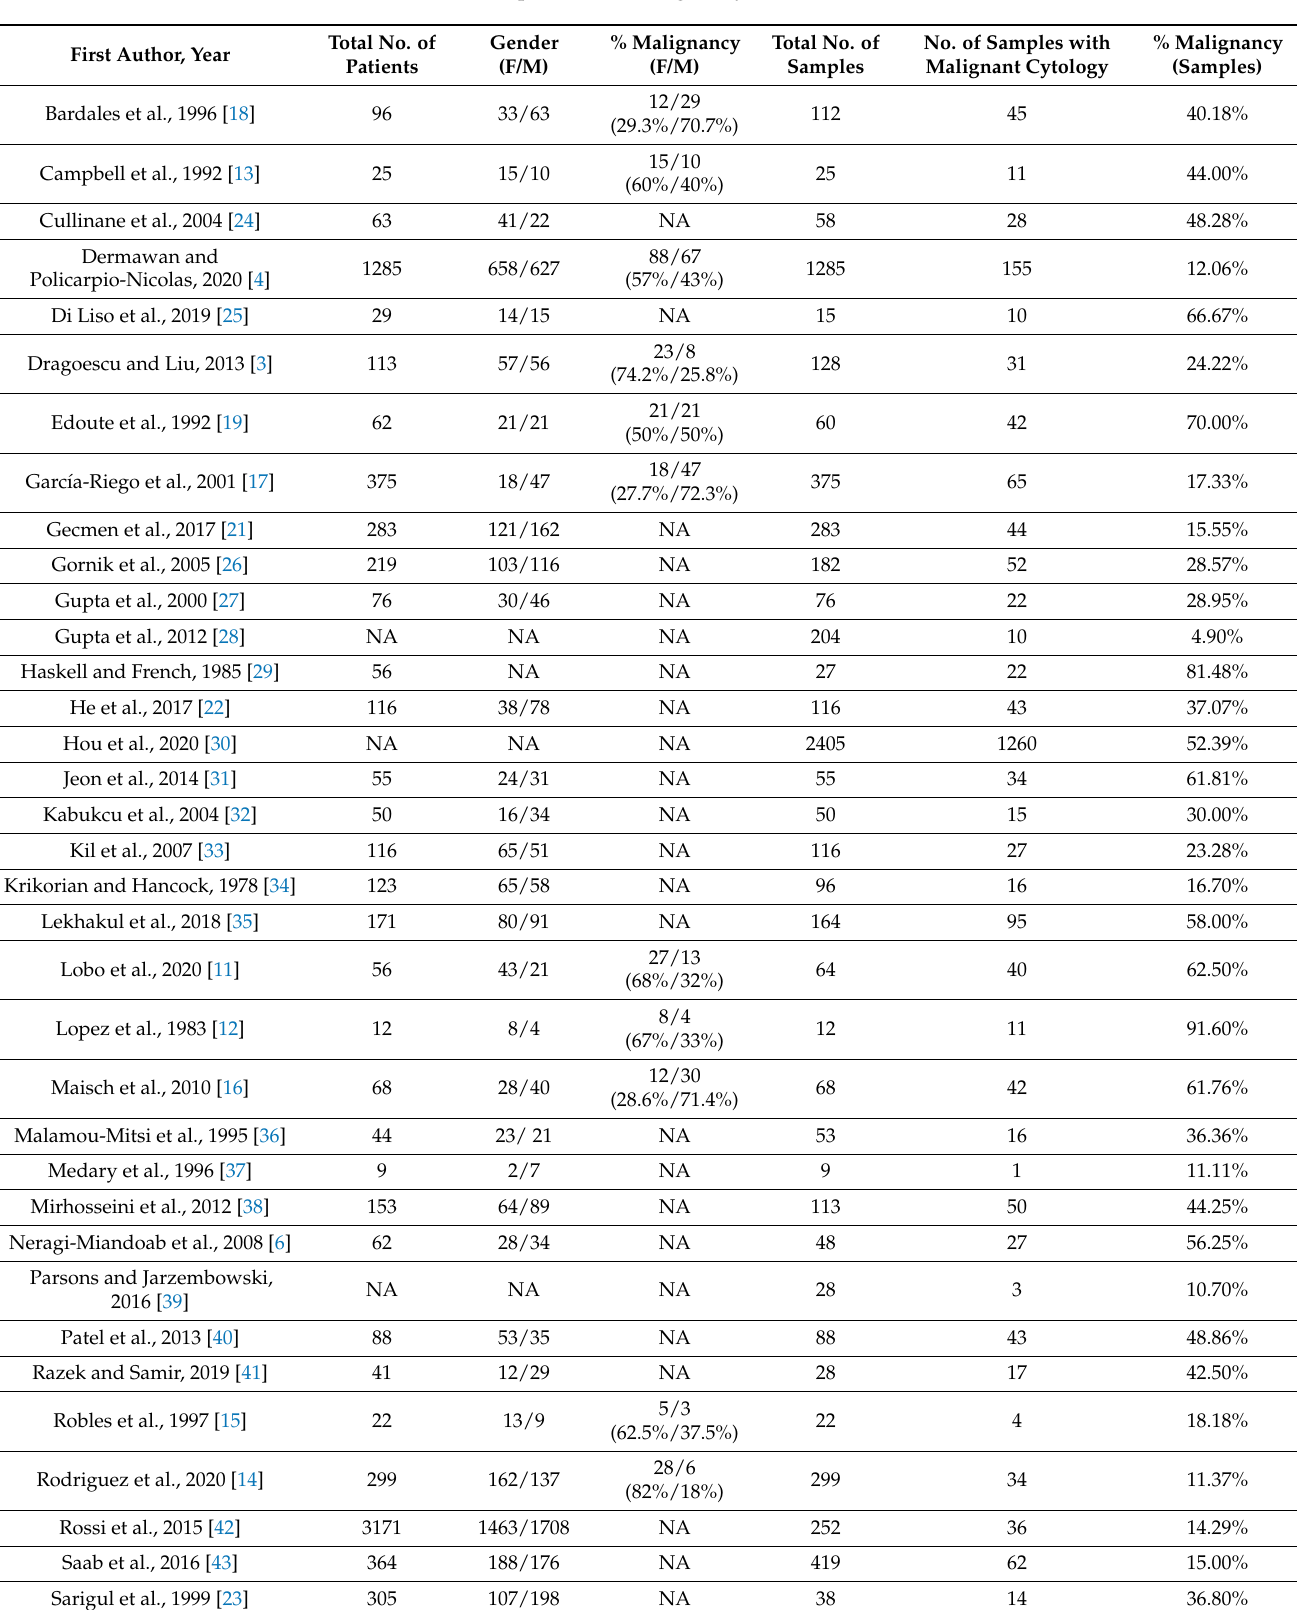
Table 2. Presence of pericardial malignancy in the included